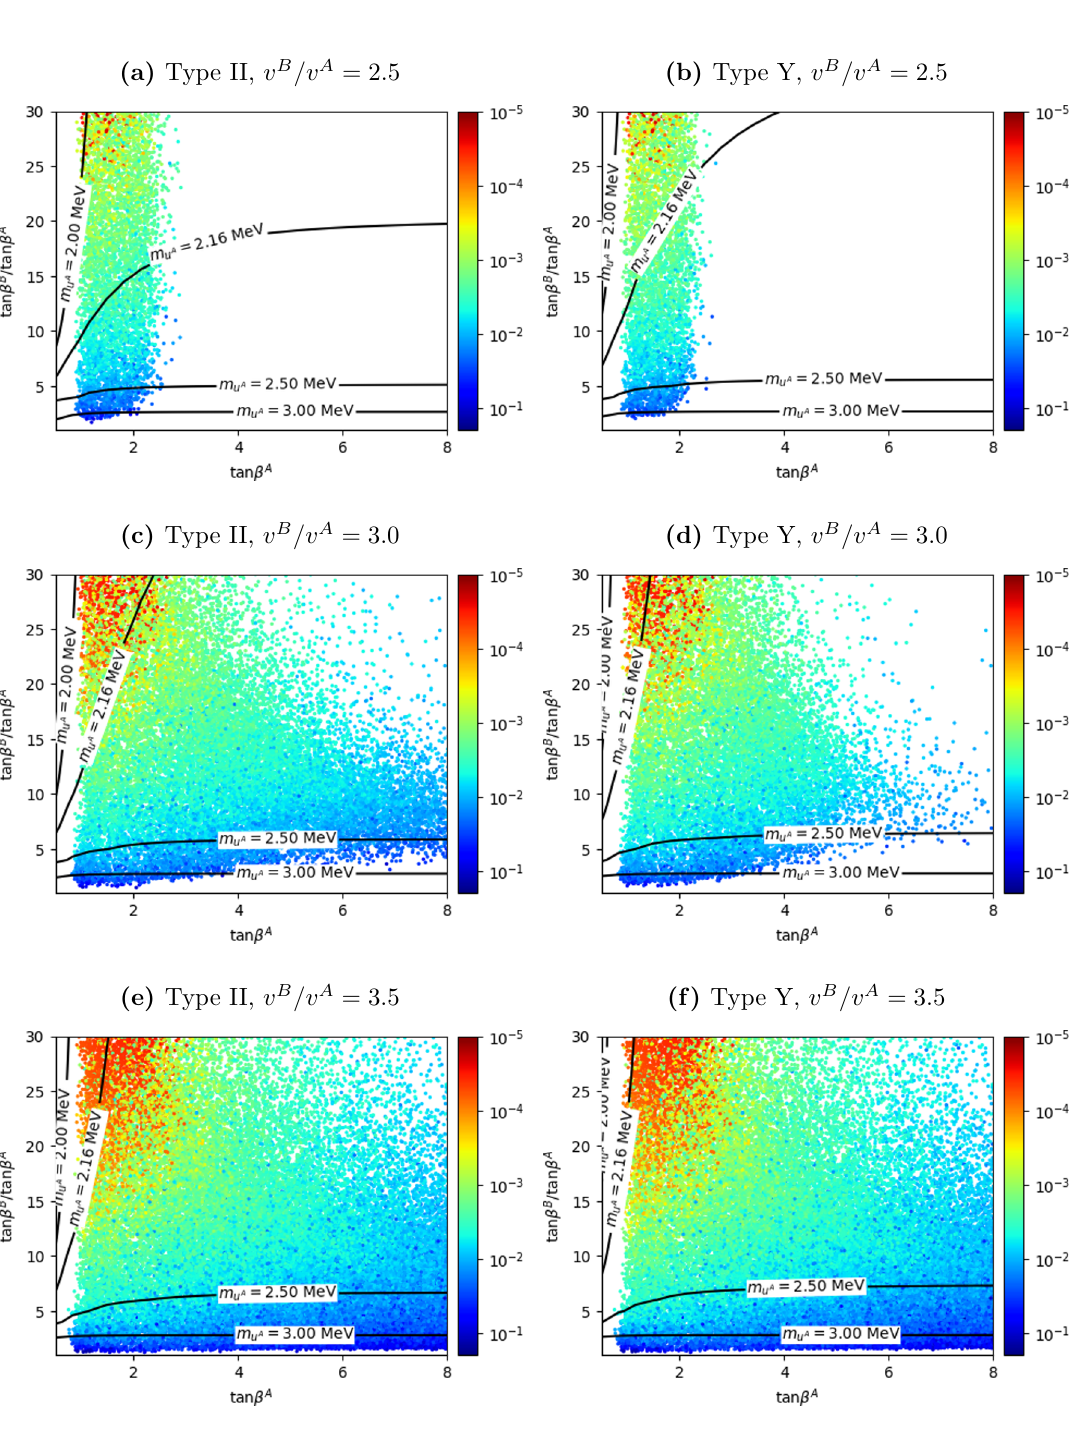
, di(cid:11)erent v B =v A , di(cid:11)erent types and u A and T (cid:18) . 1 2